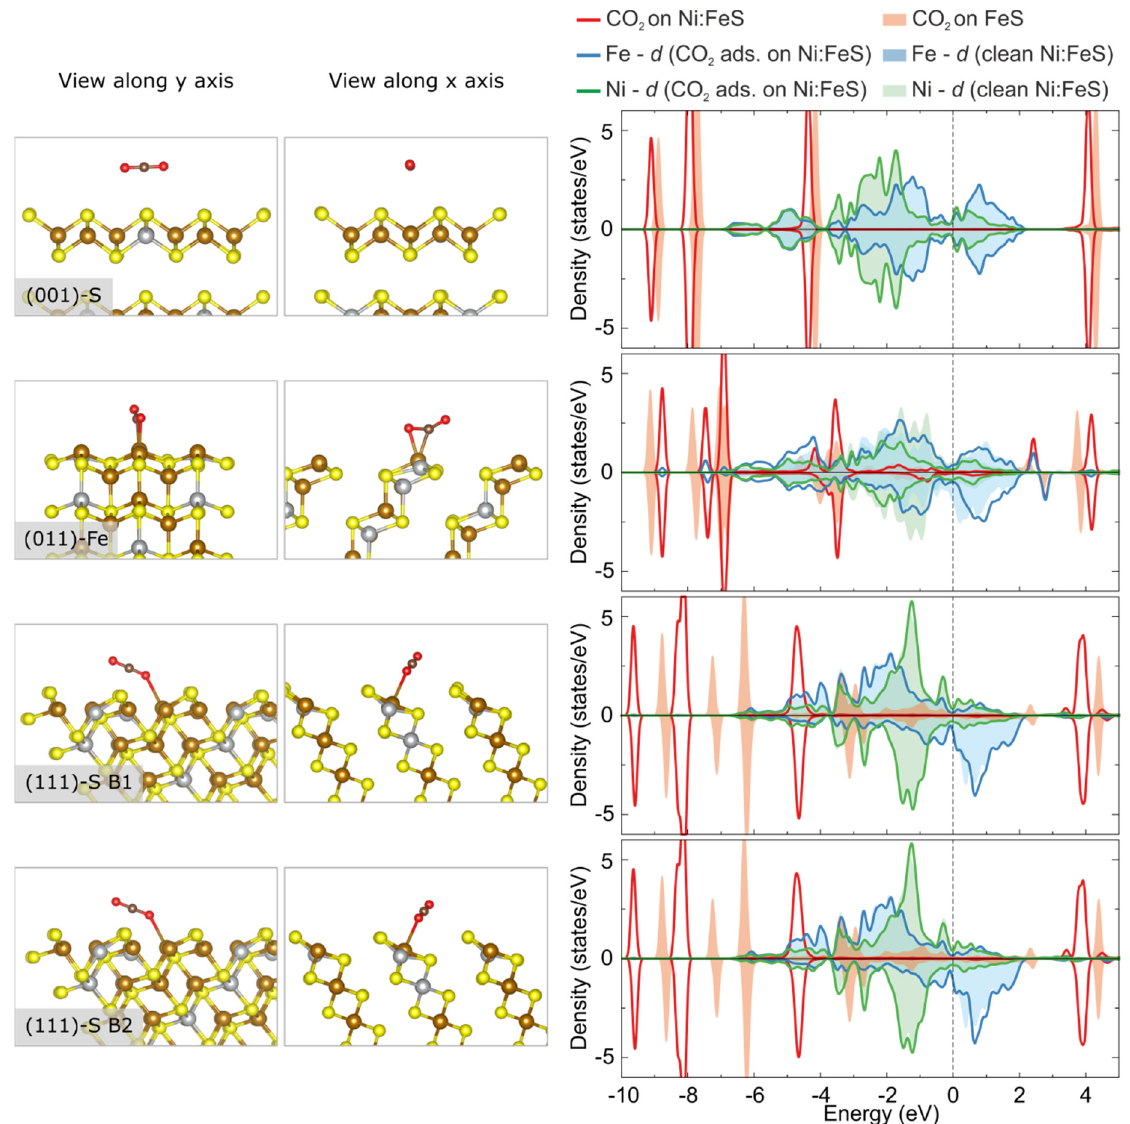
Figure 5. Crystal structure of the CO 2 molecule adsorbed on the Ni-doped surfaces of FeS (left) together with the accompanying electronic densities of the state (right).